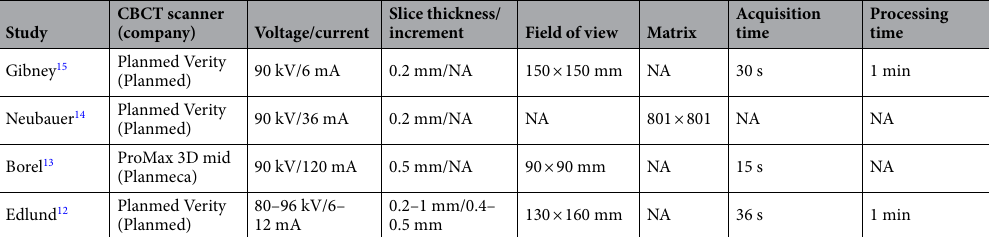
Table 2. Details of the CBCT protocol. NA not available.